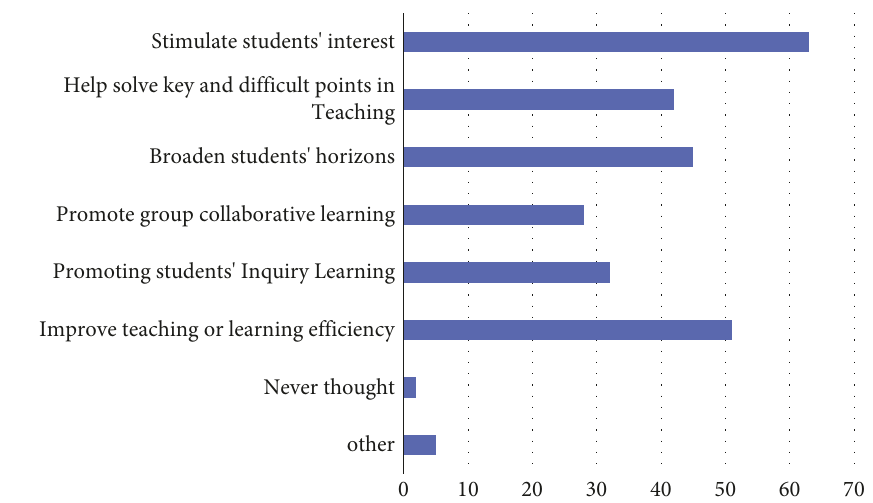
Figure 7: Survey of teachers’ choice of using information technology for teaching